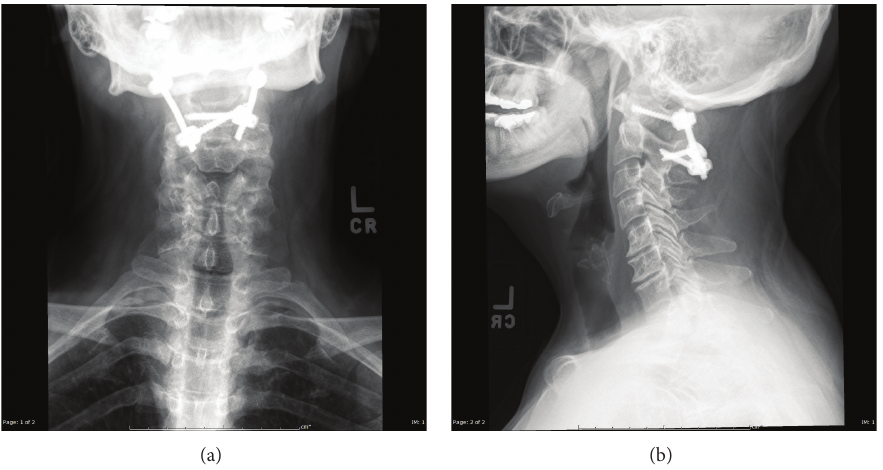
Figure 8: AP (a) and lateral (b) X-rays depicting a C1/2 fusion using C2 translaminar screws.